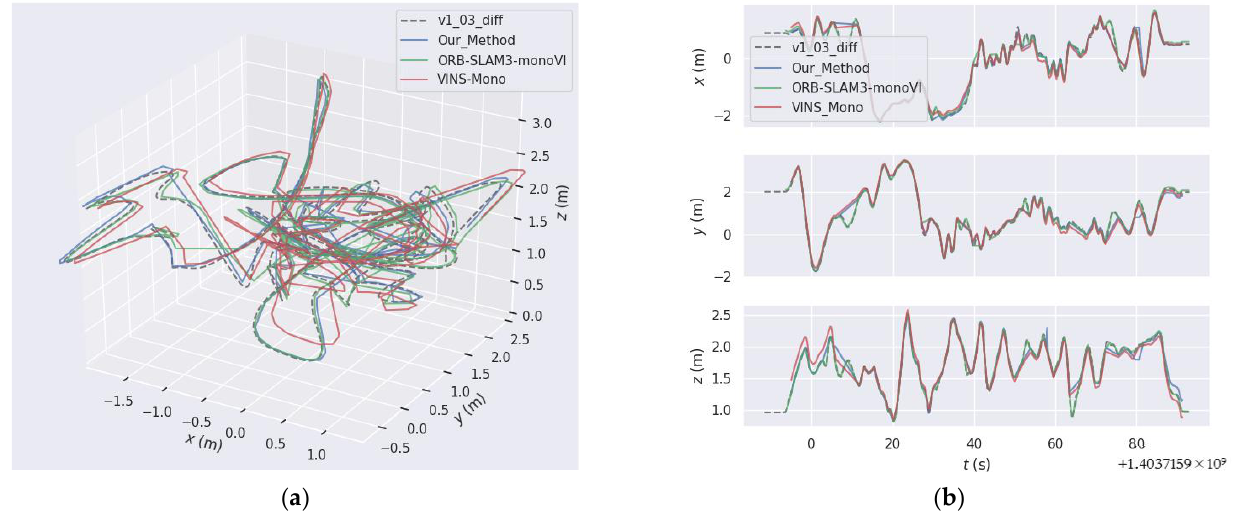
Figure 9. The comparison of trajectories between our method, VINS-Mono and ORB-SLAM3 with the trajectory truth, v1_03_diff. ( a ) trajectory absolute errors shown in 3D space; ( b ) trajectory absolute errors shown in x, y and z axes, respectively.